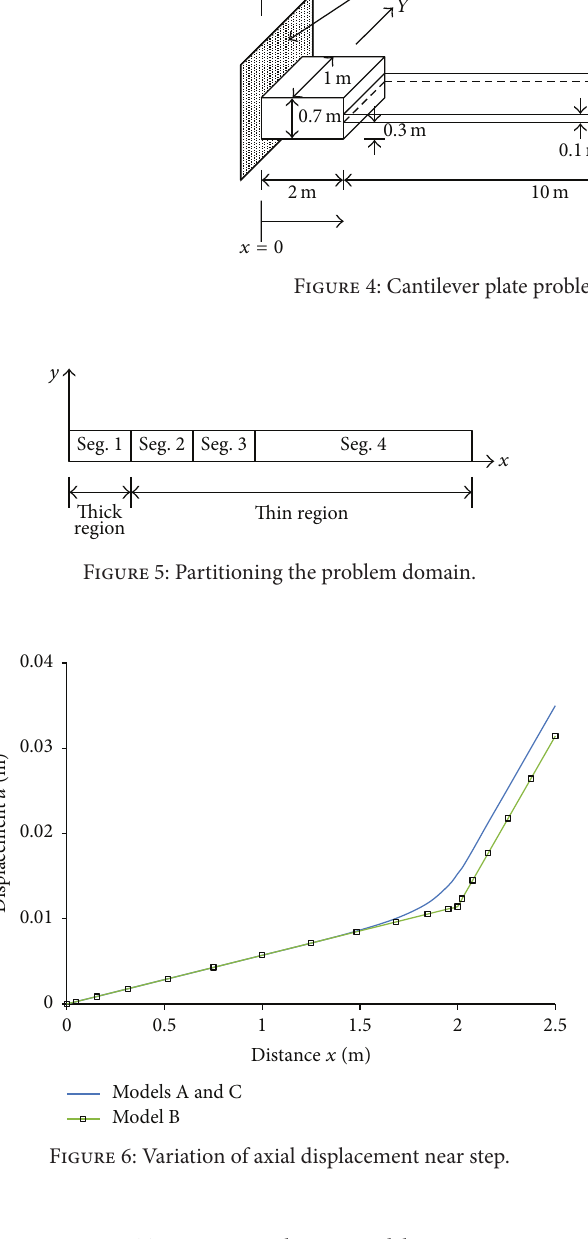
Table 1: Finite element models.